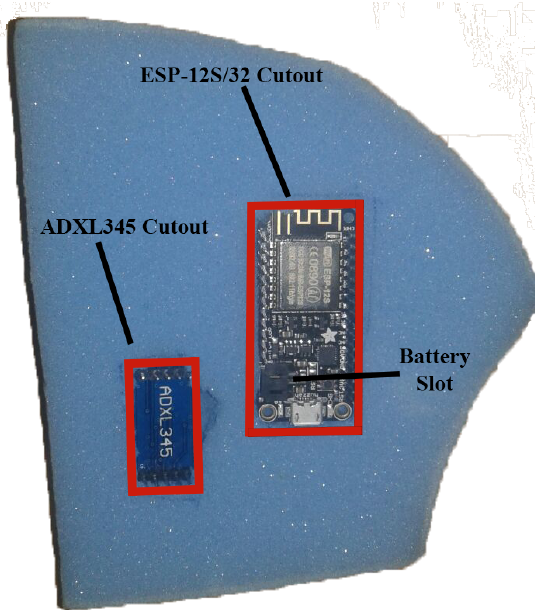
Figure 5. Accelerometer (ADXL345) and Programmable WiFi/Bluetooth Module (ESP-12S/32) cutout for internal fitting